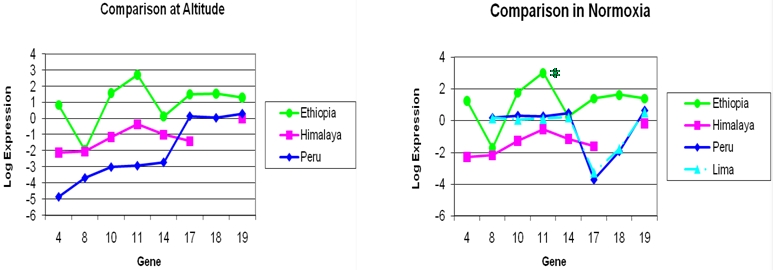
Expression signatures of a subset of genes examined in Ethiopians, Himalayans and Andeans.Comparisons at altitude (left) and in normoxia (right), same (control) subjects in each ethnic group. Note the lack of change in expression signatures with normoxia in the Ethiopians except for (PDP1, P<0.04). In Himalayans none of the gene expressions were changed by normoxia. No differences in molecular signatures between the Andean study groups (CMS and controls) except significant differences by location (normoxia in Lima). There were significant decreases in expression at altitude for most genes, except for HPH1, EPO and HPH2 in Andeans; VEGFC was not assayed in Andeans at low altitude. The genes were: #4-VEGFC; #8-PDK1; #10-EPOR; #11-PDP1; #14-PDK2; #17-HPH1; #18-EPO; #19-HPH2.